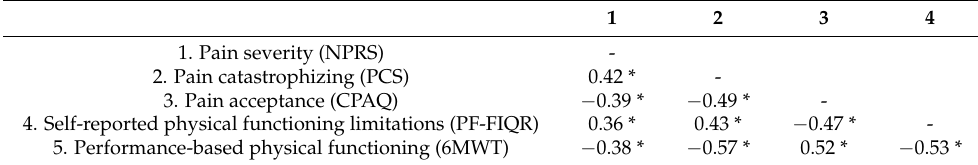
Table 2. Pearson correlation coefficients between study variables. n =